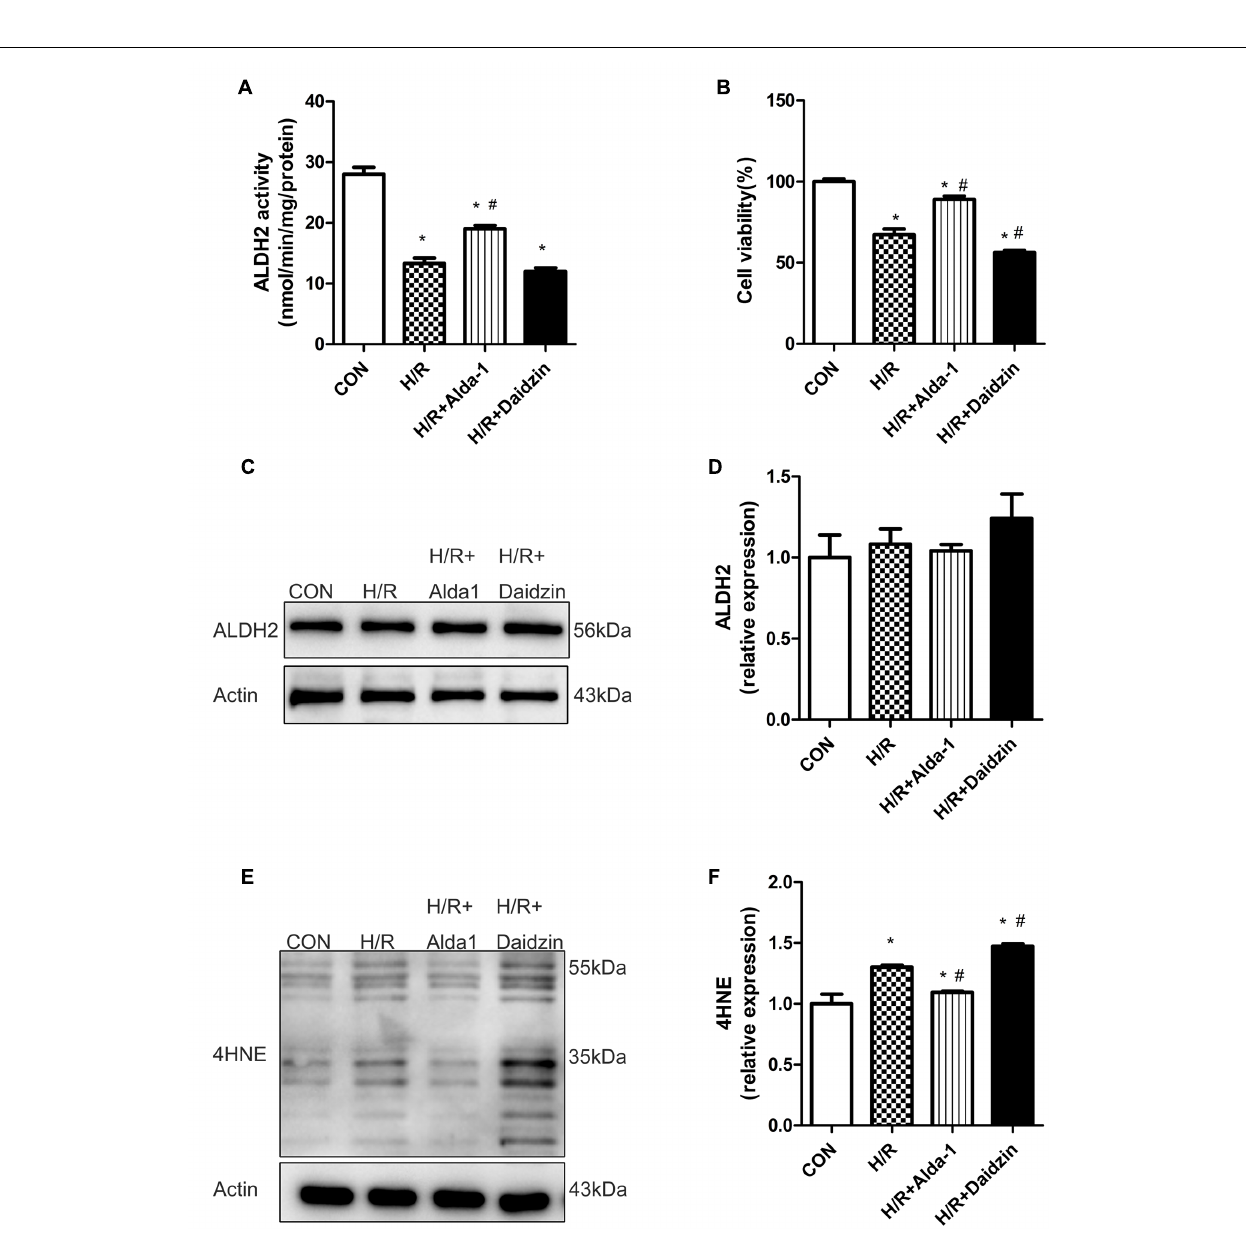
Frontiers in Pharmacology |